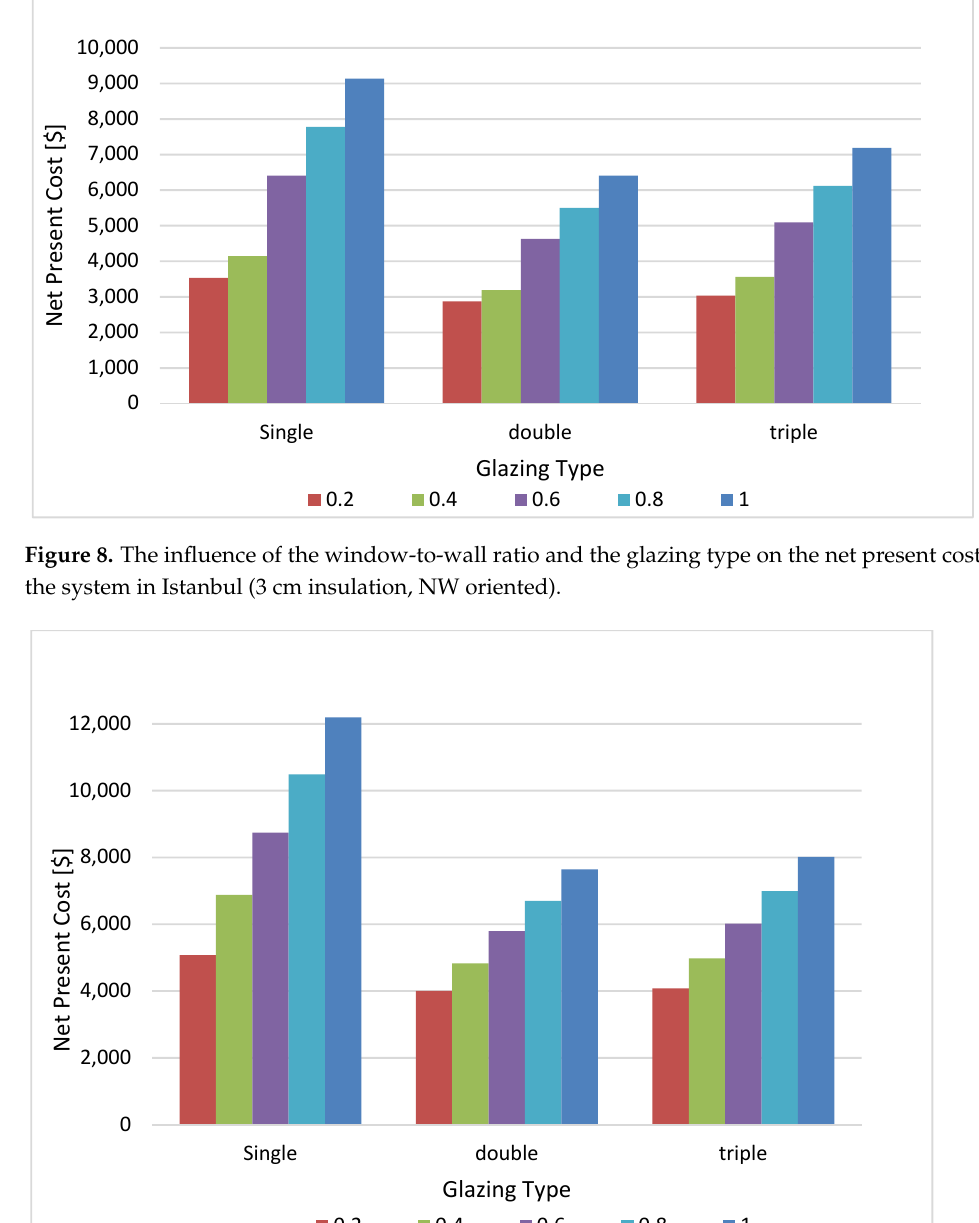
Figure 7. The influence of the window-to-wall ratio on the annual heating cost in Hakkari (3 cm insulation, NW oriented) .